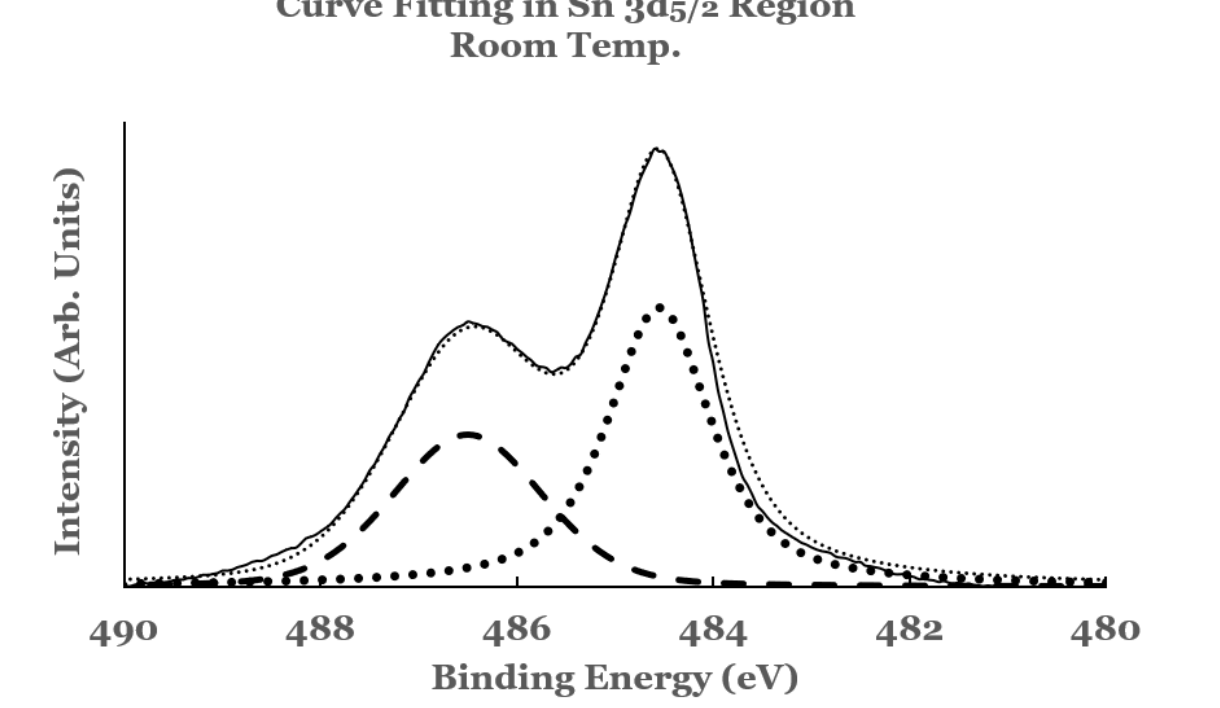
Figure 2. Curve fit for the 3d 5/2 region of tin for the 1.1 nm titanium overlayer deposited at room temperature. The thin solid line represents the experimental data. The thick dotted line represents the spectrum from elemental Sn while the thick dashed line that from SnO 2 . The thin dotted line represents the superposition from elemental Sn and SnO 2 .